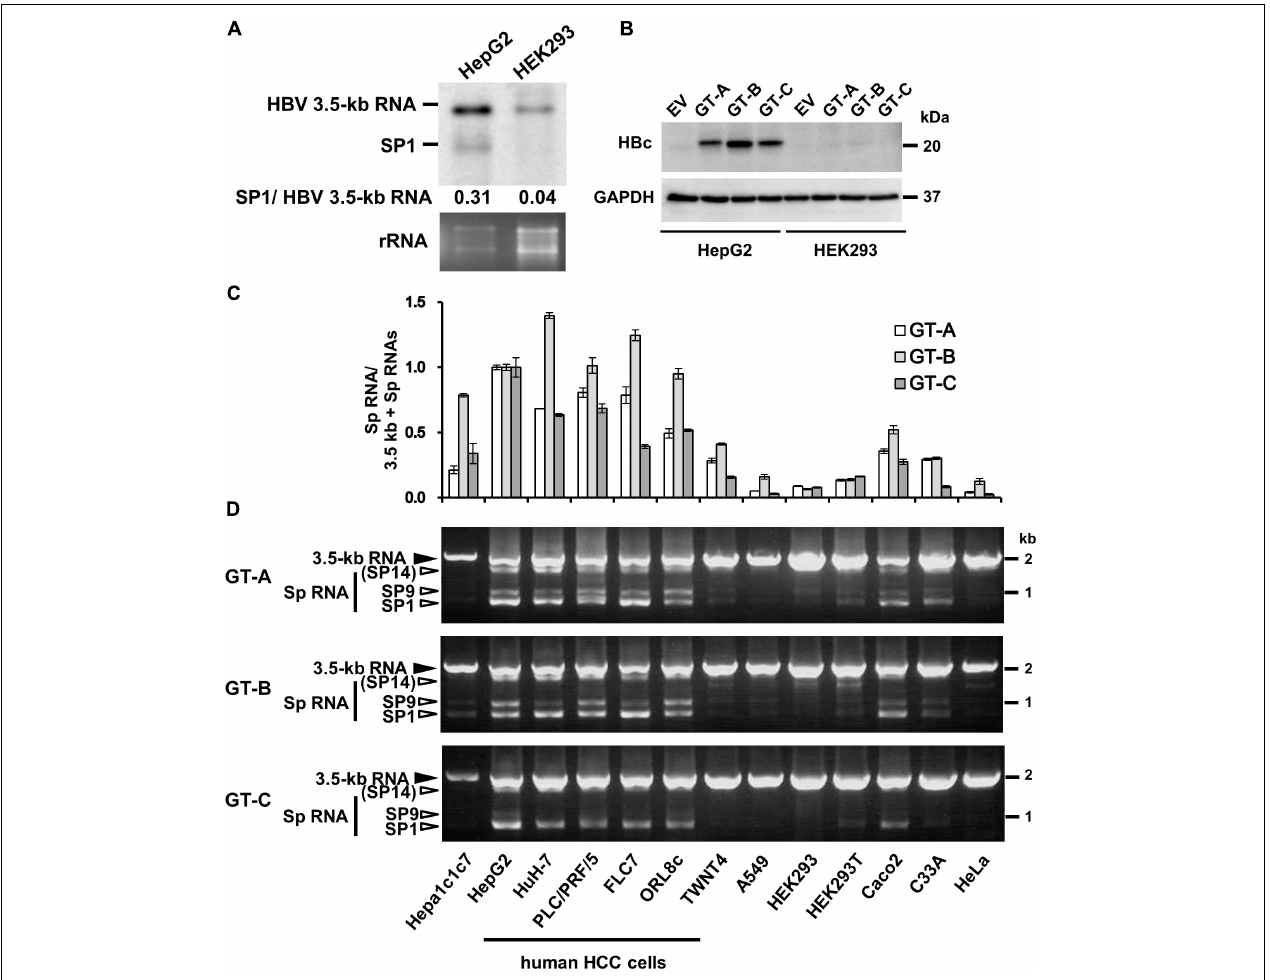
FIGURE 1 | Cell-type dependency of HBV 3.5 kb RNA splicing. (A) pUC-HB-Ce was transfected into HepG2 and HEK293 cells. Two days after the transfection, total RNA was extracted from cells and separated on an agarose gel. HBV 3.5 kb RNA and spliced RNA(s) were detected by northern blotting using HBV RNA probe (nt 1998–2447) ( Supplementary Figure S1A ). Band intensities of 3.5 kb- and SP1 RNAs on the blot were determined by ImageJ software and the ratios of SP1 RNA to 3.5 kb RNA calculated were indicated. Ethidium bromide-stained agarose gel electrophoresis of 18S ribosomal RNA (rRNA) was also shown (bottom). (B) HepG2 and HEK293 cells transfected with pUC-HB-Ae (GT-A), -Bj56 (GT-B), -Ce (GT-C) and an empty vector (EV) were analyzed by immunoblotting to detect HBcAg and glyceraldehyde-3-phosphate dehydrogenase (GAPDH). (C) qRT-PCR analysis was performed to determine the levels of 3.5 kb RNA and spliced RNA in 13 kinds of cells transfected with pUC-HB-Ae (GT-A), -Bj56 (GT-B), and -Ce (GT-C). The quantity ratios of the spliced RNAs to total 3.5 kb RNA derived RNA species were calculated and those in HepG2 cells were set to 1. Values shown represent means ± SD obtained from three independent samples. (D) Total RNAs